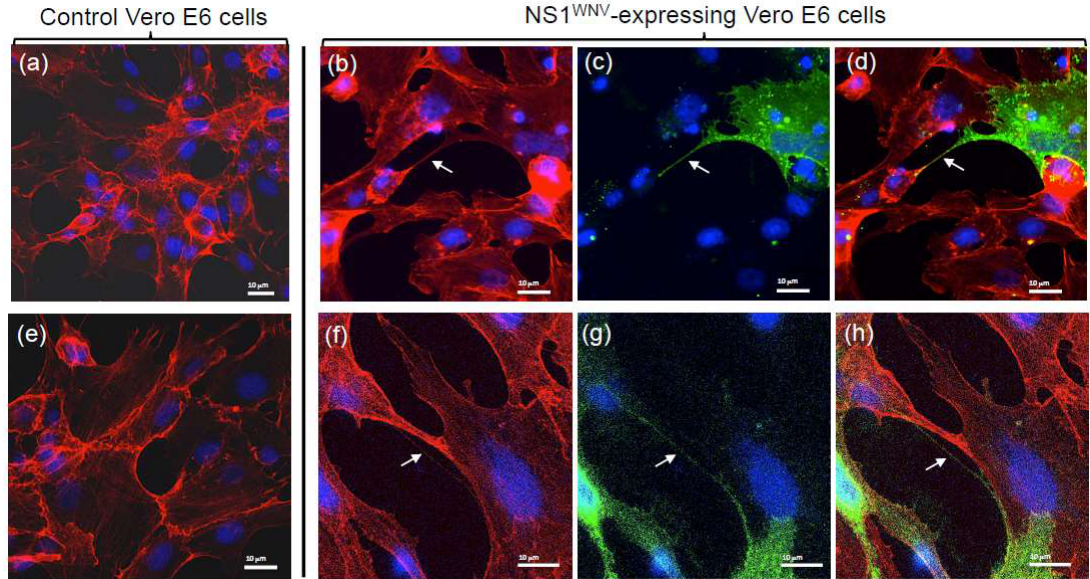
Figure 6. Actin network in recombinant NS1 WNV -expressing Vero E6 cells. Vero E6 cells were transfected with control empty plasmid pcDNA3.1 ( a , e ), or with pNS1 WNV-IS98 ( b – d , f – h ). Cells were analyzed at 24 h pt by confocal fluorescence microscopy, using rhodamine–phalloidin for the visualization of actin filaments and specific rabbit antibody for the immunolabeling of NS1 WNV . ( a , b , e , f ) Actin signal; ( c , g ) NS1 WNV signal; ( d , h ) merged signals. Nuclei were stained in blue using DAPI reagent. ( a – d ) Low magnification; ( e – h ) high magnification. Arrows point to actin- and NS1-containing cellular TNT-like projections.